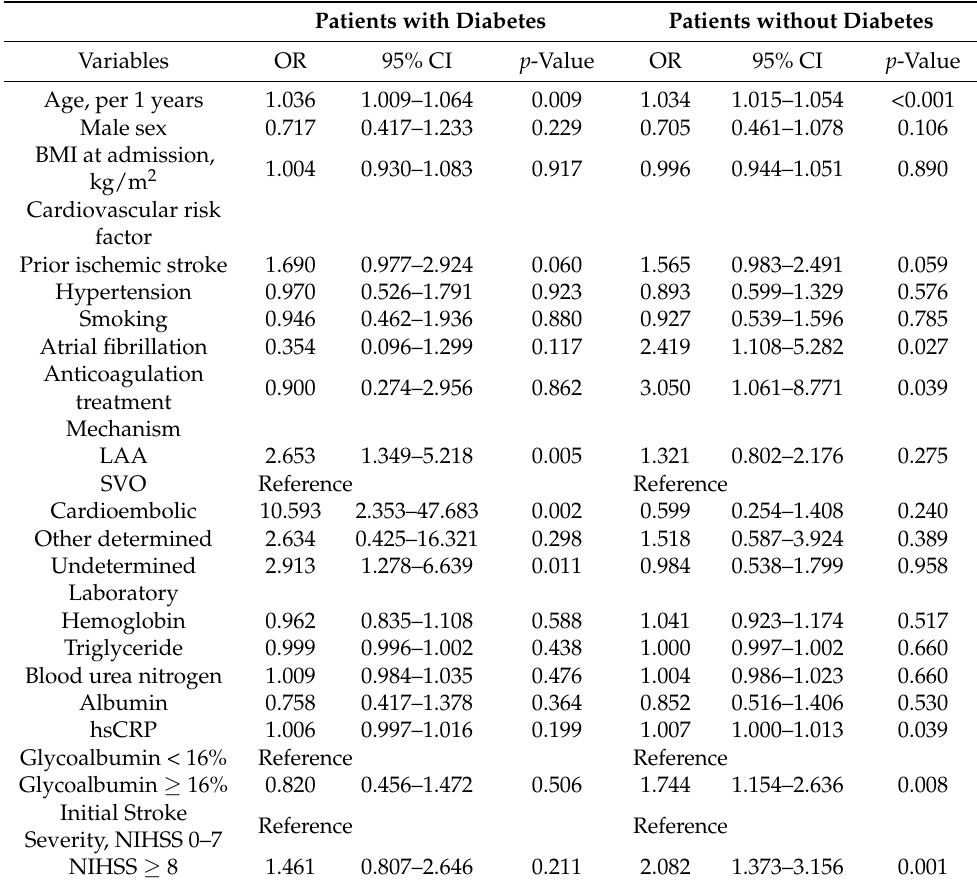
Table 5. Effect of GA on unfavorable short-term outcomes (compared to favorable 3-month mRS 0-2) based on the presence of